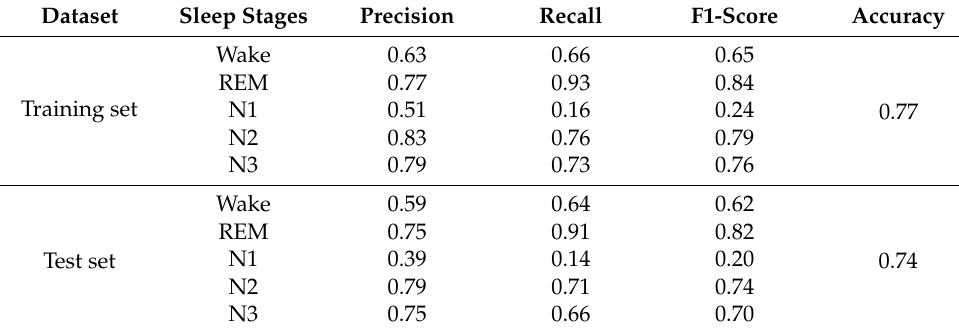
Table 4. Performance for five-class sleep staging in the test